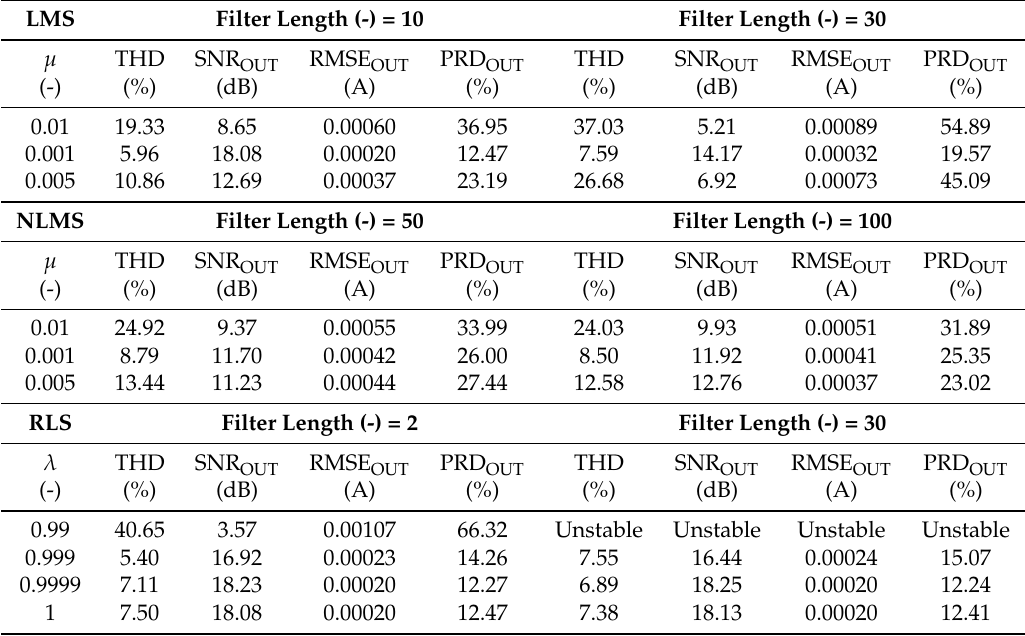
Table 3. Results of the experiment using adaptive algorithms for a settled filter (from 100 to 600 ms).